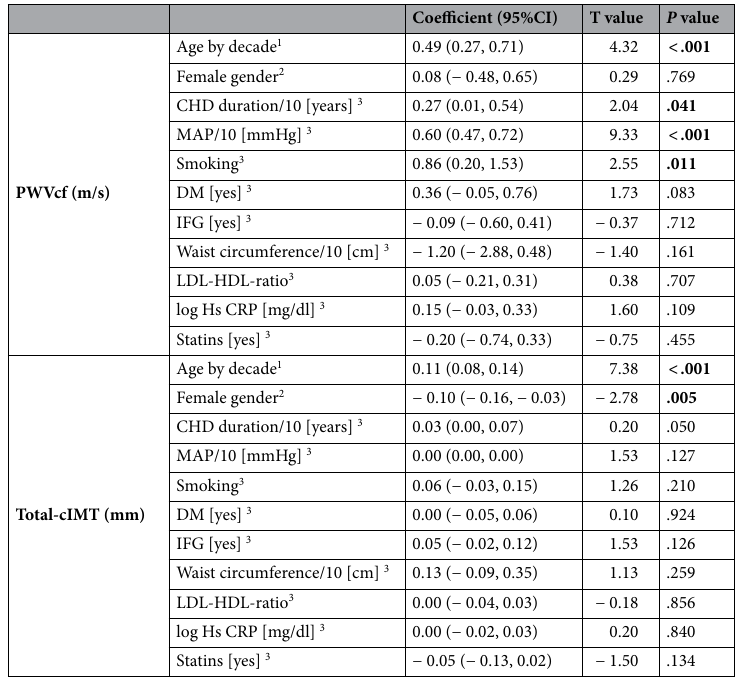
Table 3. Linear regression analysis for PWVcf and total-cIMT. PWVcf carotid-femoral pulse wave velocity, total-cIMT total carotid intima-media thickness, CHD coronary heart disease, MAP mean arterial pressure,